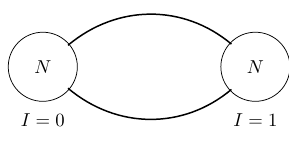
Figure 1 . The 4 d N = 2 quiver gauge